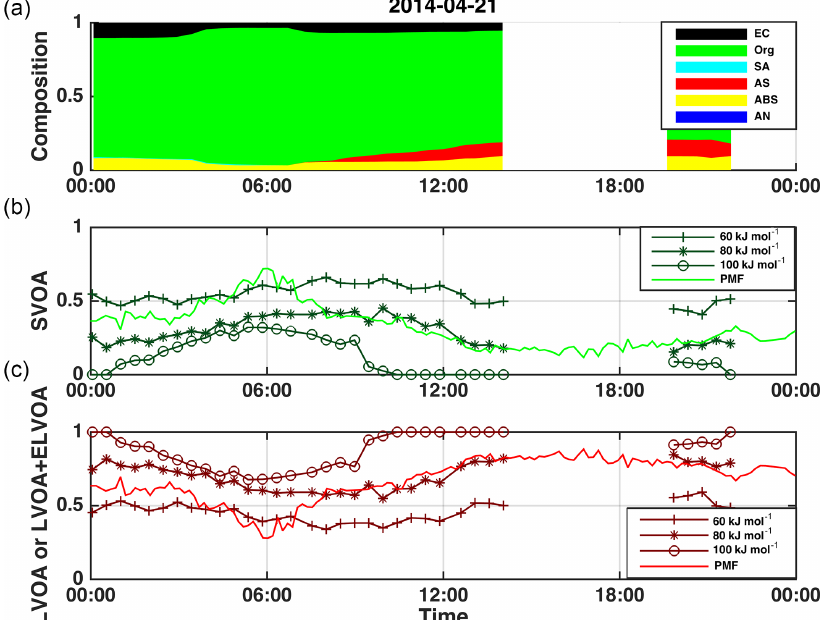
Figure 7. Time series of particle chemical composition obtained from HR-AMS (a) , mass fractions of VTDMA- and PMF-derived